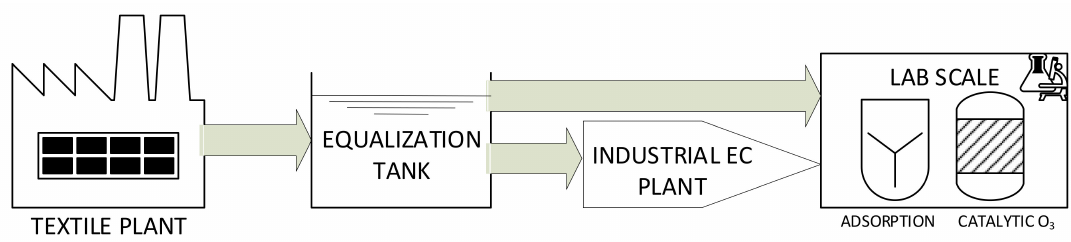
Figure 7. The production–treatment cycle–wastewater